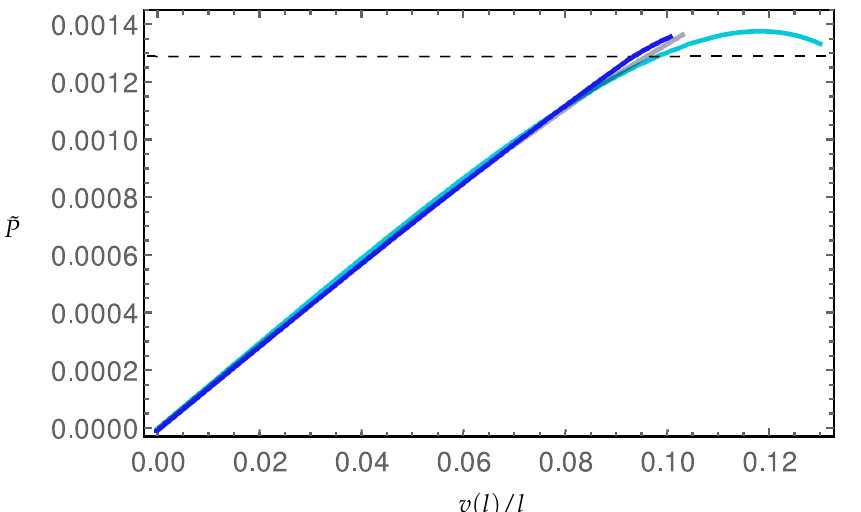
Figure 7. Tip force: evolution of the tip displacements while the increasing of the amplitude of the load ( ˜ P : = P v ). Black dashed line: load condition of Figure 6; blue line: perturbation π R ( G e h e + G i h i ) solution; light blue line: finite difference method; gray line: